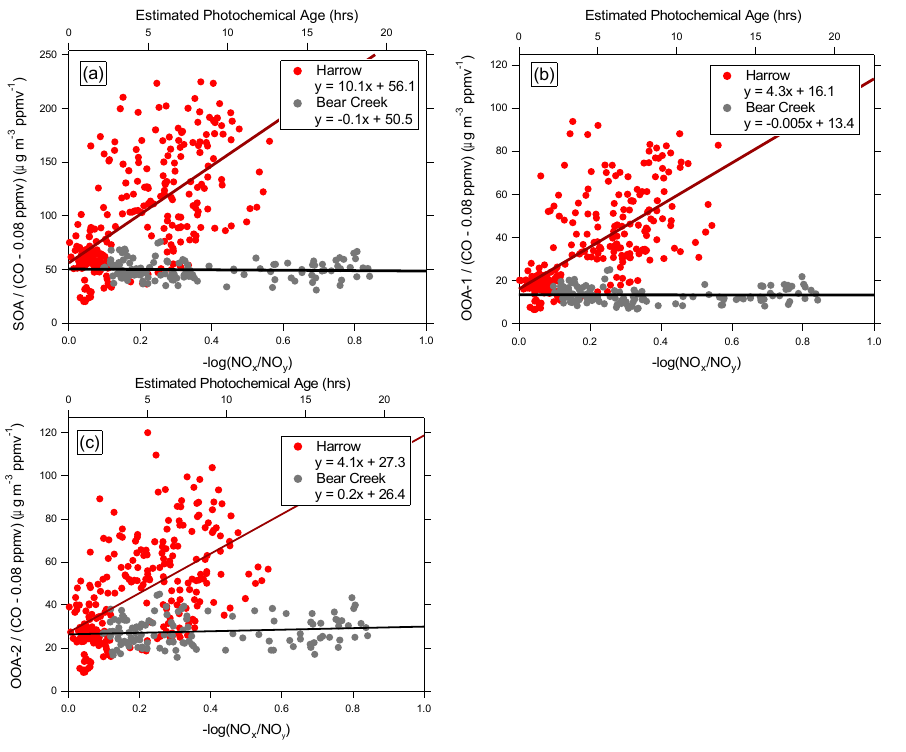
Fig. 7. Photochemical aging at Harrow and Bear Creek during Detroit/Windsor outflow (see Fig. 3 blue period, and Fig. 6). CO-normalized values for (a) SOA (estimated as OOA-1 + OOA-2 + UNKN), (b) OOA-1, and (c) OOA-2 are plotted as a funciton of − log(NO x /NO y ) . For curve fitting results, slopes are reported in µgm − 3 ppmv − 1 h − 1 and intercepts are in µgm − 3 ppmv − 1 .